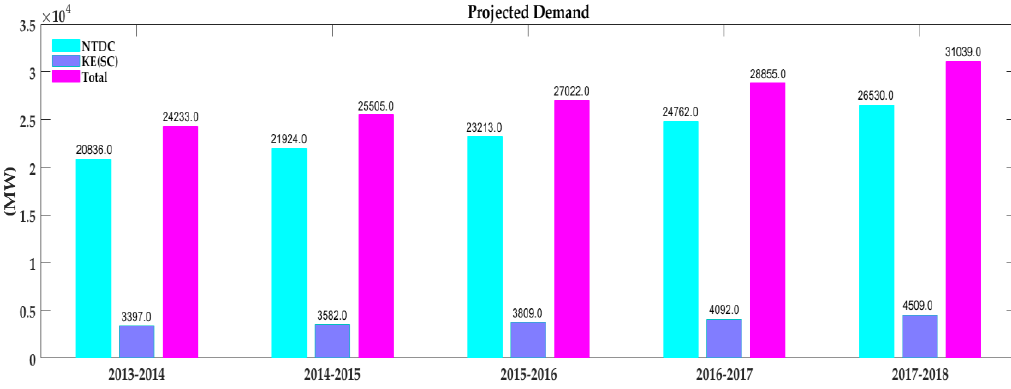
Figure 2. Demand and supply projection for fuels, domestic fuel production and fuel imports.